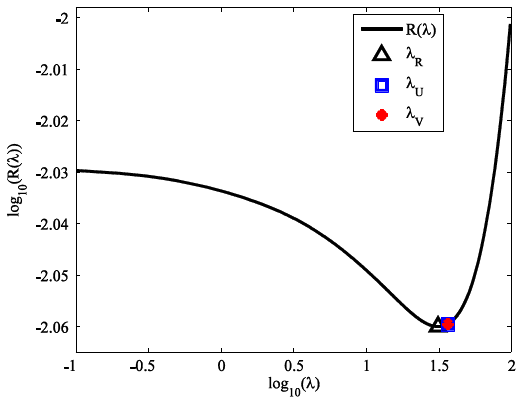
Figure 2. Predictive mean square error (MSE) versus λ in logarithmic scale.